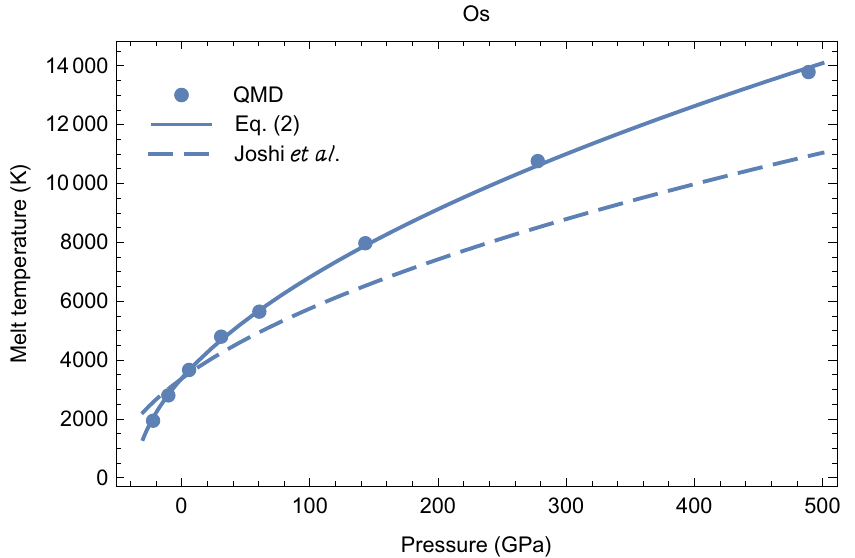
Figure 8. The melting curve of Os: VASP results (bullets) and the corresponding Simon equation, Equation (2), vs. the theoretical model of Joshi et al. [16].